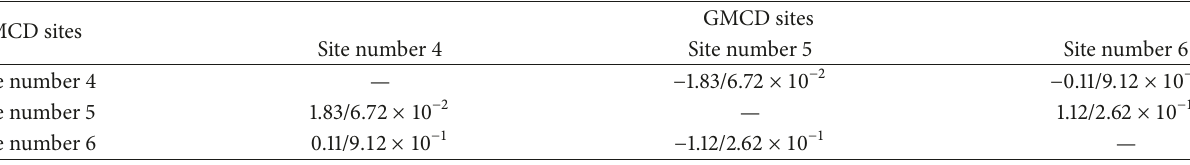
Table 4: Calculated 𝑧 -values/ 𝑝 values of behavior indicators among GMCD Sites.